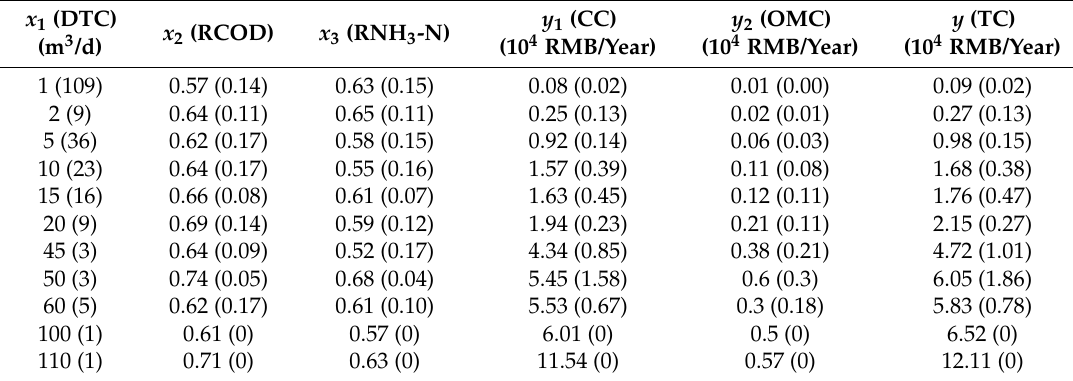
Table 1. Mean value of parameters for the selected